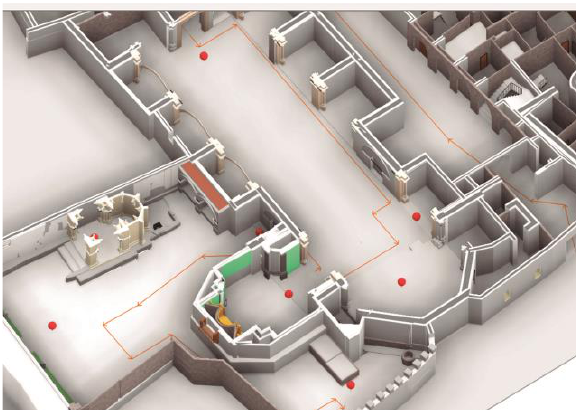
Figure 6. 3D view of the tourist itinerary.